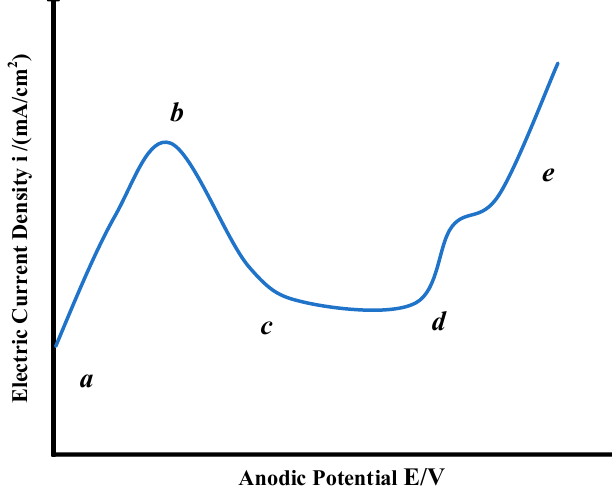
Figure 14. Polarization curve of NaClO 3 .